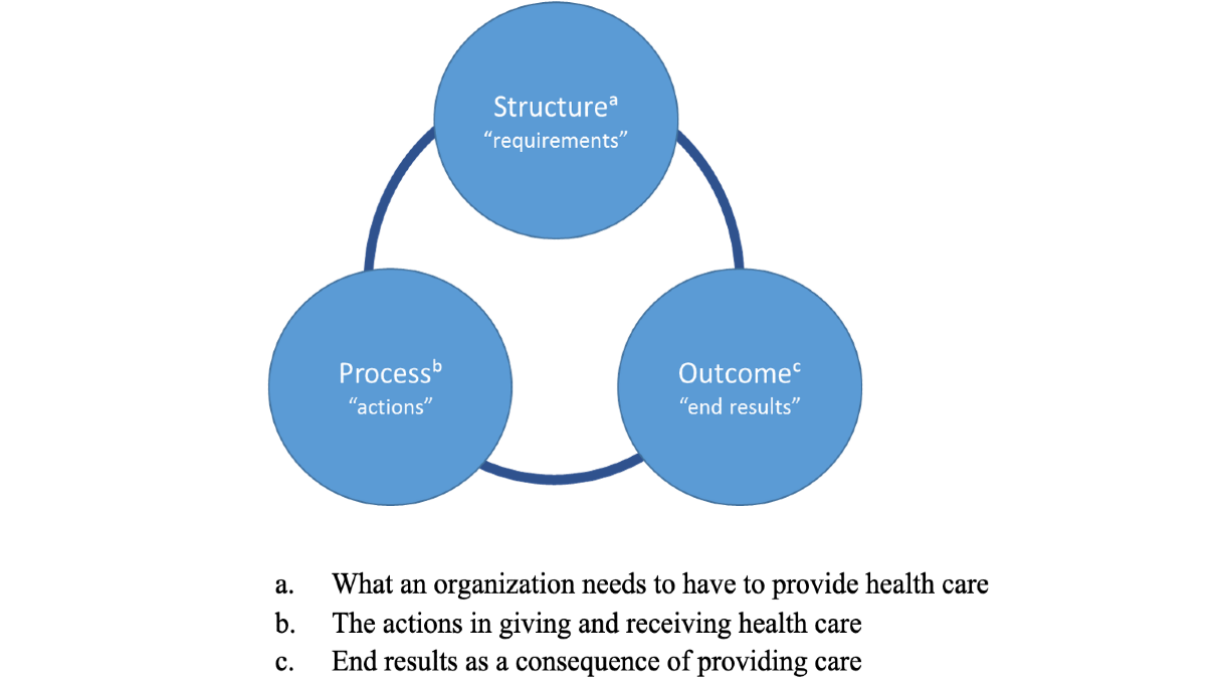
Figure 1. Donabedian Structure-Process-Outcome